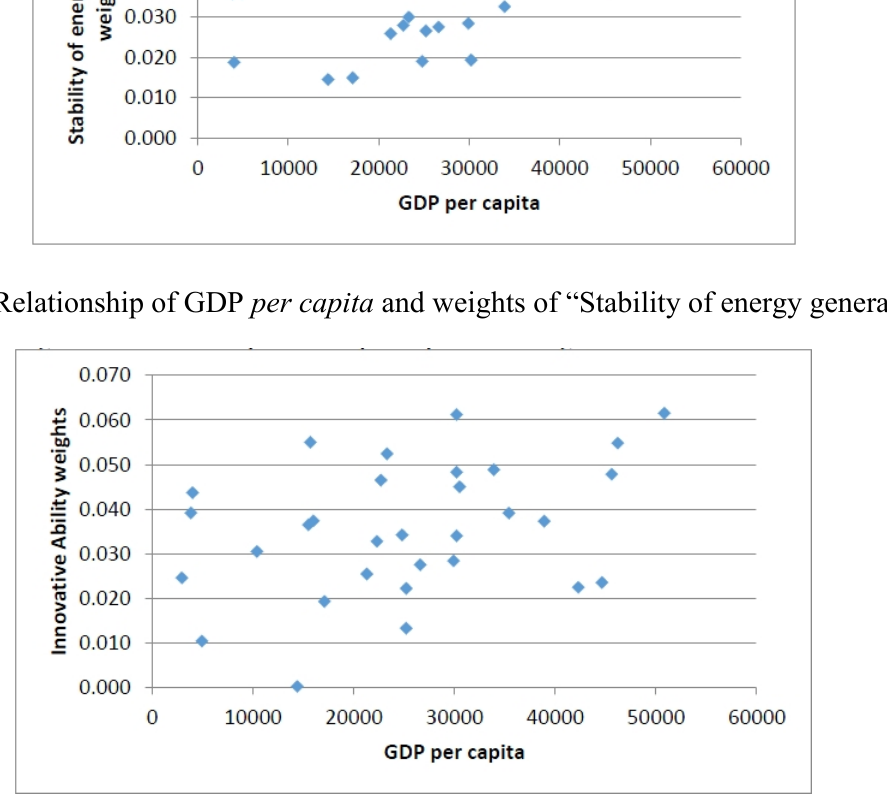
Figure 9. Relationship of G56DP per capita and weights of “Innovative